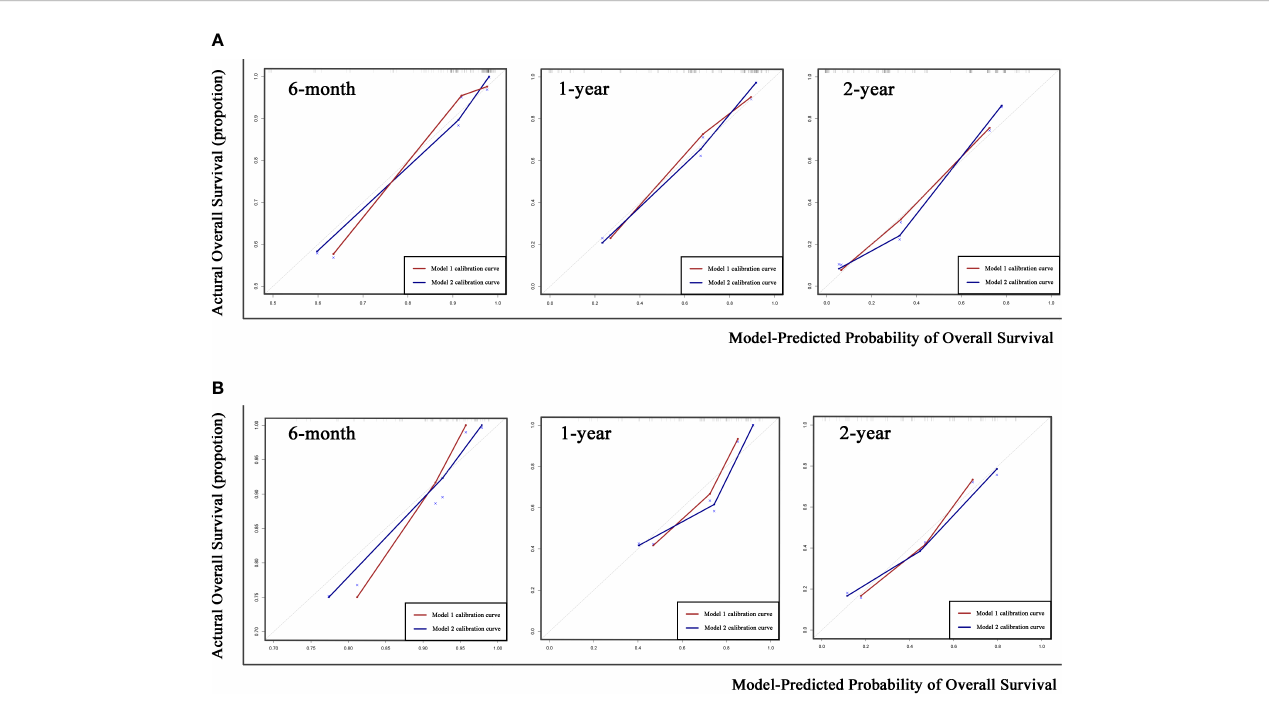
FIGURE 6 Calibration curves of the two prediction models for 6-month, 1-year, and 2-year overall survival (OS) in the training cohort (A) and validation cohort (B) . Gray dotted lines represent the calibration curve of the most ideal predictive